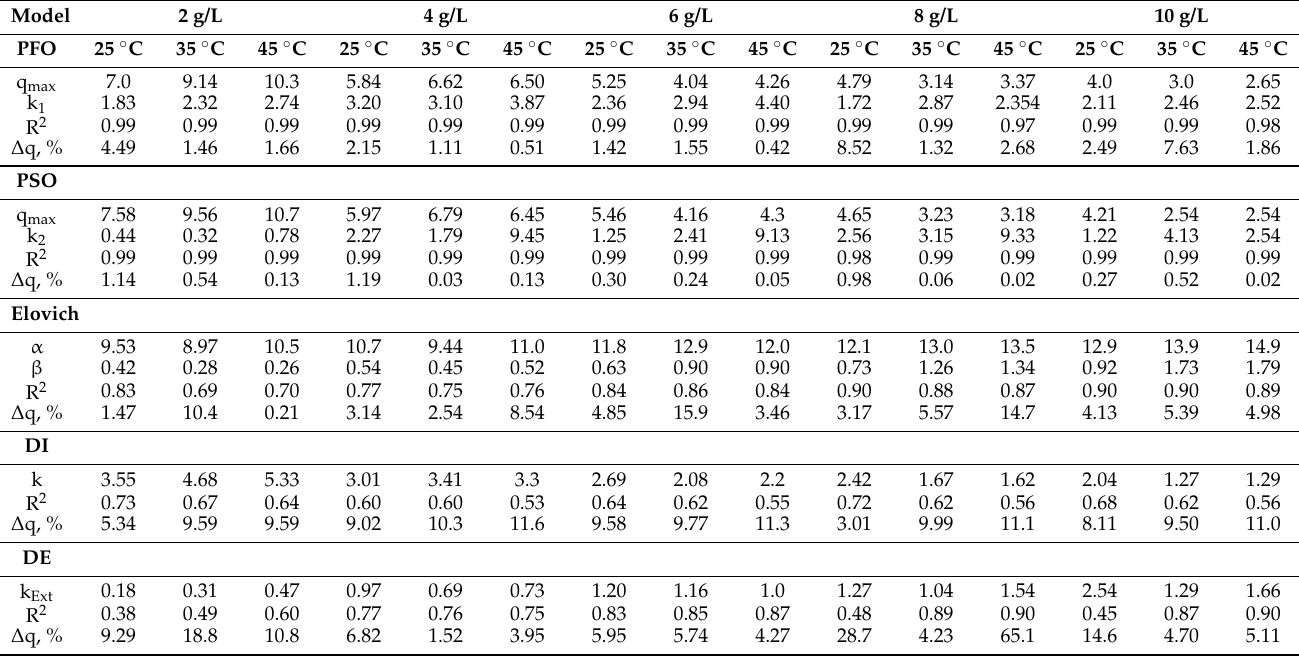
Table 6. Kinetic constant of DNS adsorption patterns in